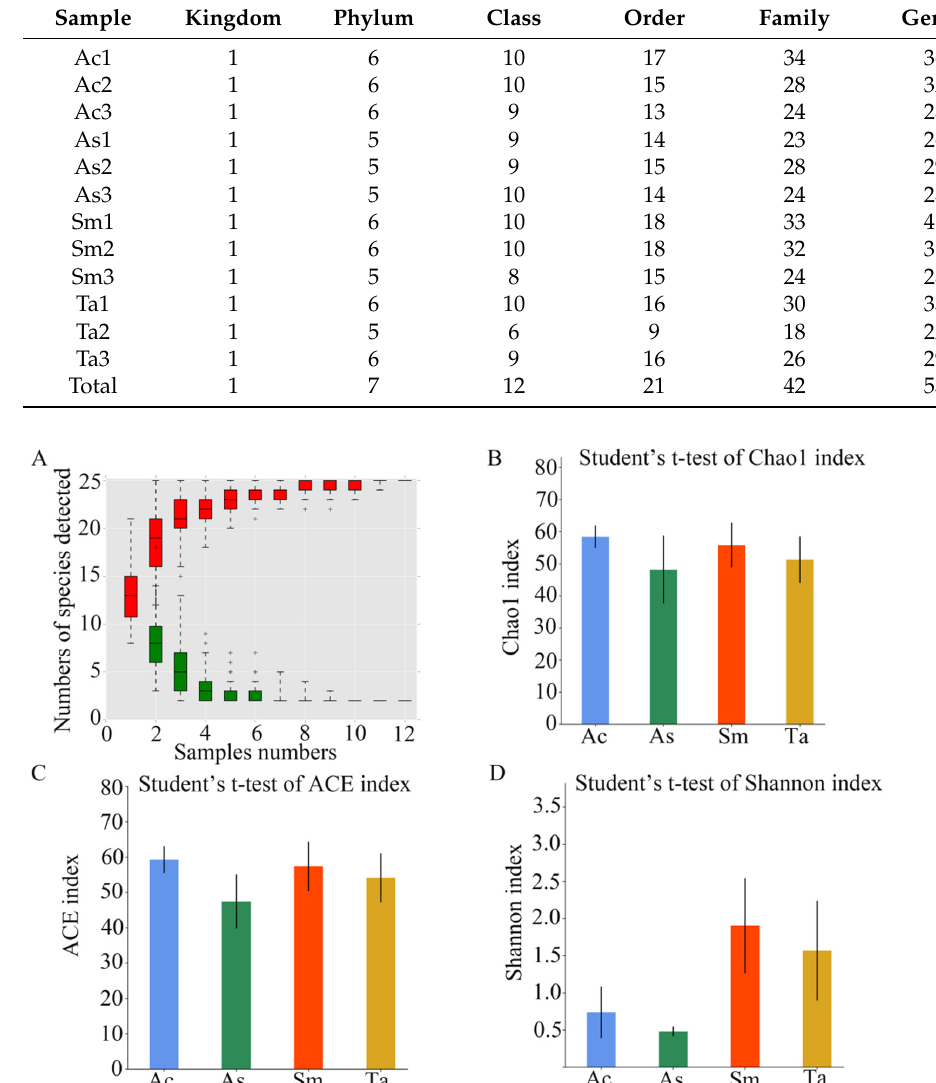
Figure 1. The results of α -diversity analysis. ( A ) Species discovery curve. (A single red box in this figure represents the total number of species detected in randomly selected samples. The cumulative curve is composed of the totality of red boxes, which represents the rate of new species appearing under continuous sampling; a single green box in this figure represents the number of common species detected in a given number of samples. The set of green boxes form the common quantity curve, which represents the rate of common species detected under continuous sampling). ( B ) Chao1 index of the four species of grasshoppers. ( C ) ACE index of the four species of grasshoppers. ( D ) Shannon index of the four species of grasshoppers. Ac, Acridia chinensis ; As, Atractomorpha sinensis ; Sm, Sphingonotus mongolicus ; Ta, Trilophidia annulate Table 3. The average value of the Alpha diversity index of each sample.